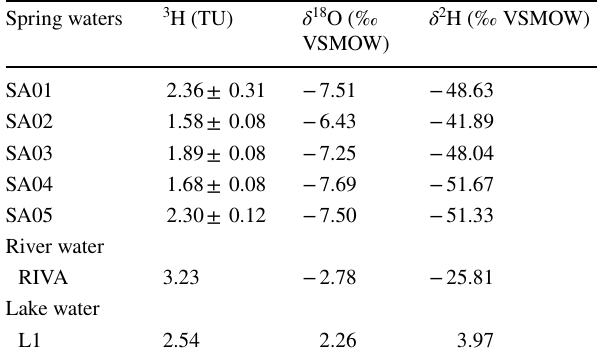
Table 2 Isotope data of spring, river, and lake waters Spring waters